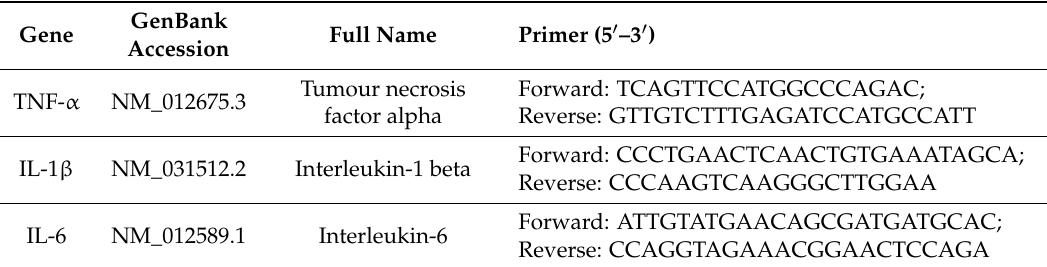
Table 1. The primer sequences used for real-time PCR assay in